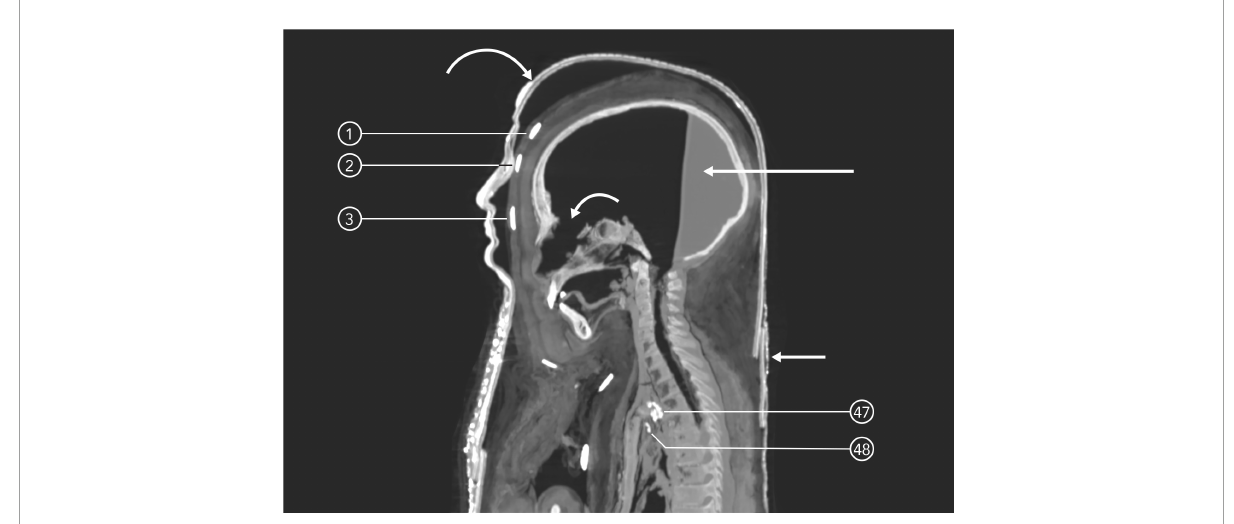
FIGURE8 Mid-sagittal computed tomography (CT) image of the wrapped mummy TR 21/11/16’s head at the Cairo Egyptian Museum shows the skull, bandages, and mask. Evidence of brain removal as part of the mummification through a skull base defect (short curved arrow) and resin level at the back of the emptied skull (long straight arrow). The head cartonnage mask is formed of multiple layers (long curved arrow) and shows a fracture at its lower back (short straight arrow). Three dense gold scarab amulets are placed on the midline of the surface of the wrapped head beneath the mask; 1: on the vertex; 2: on the forehead; 3: on the glabella. Two quartz/faience amulets ae seen inside the upper chest cavity: 47: Udjat and 48: Right angle amulet.